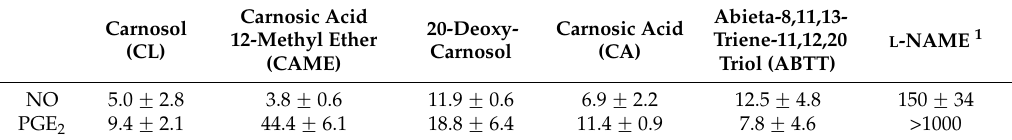
Table 1. IC 50 values for abietane diterpene in NO and PGE 2 production.